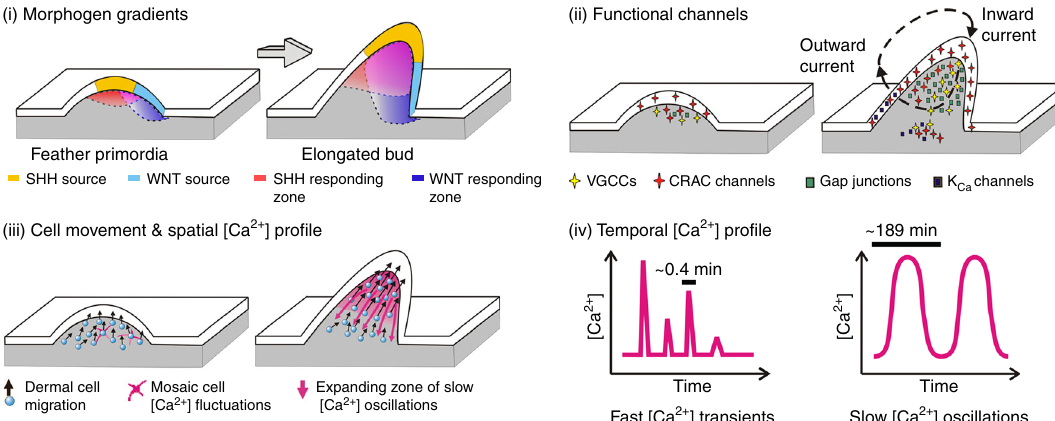
Fig. 9 Biochemical and bioelectric signals guiding directed mesenchyme cell migration in feather. SHH and WNT7A protein produced in the epithelium diffuse into the underlying mesenchyme to induce the SHH and WNT-responding zone, respectively. Together they activate Connexin-43 expression to compose intercellular gap junction channels. Heterogeneously distributed VGCCs and CRAC channels contributed to the inward current observed at posterior – distal part of elongating feathers, while activation of Ca 2 + -activated K + channels may contribute to the outward current at anterior-basal part of feathers. The gap junction network establishes a low-resistance electrical path across feather mesenchyme, homogenizing differential Ca 2 + channel activities among cells to allow synchronized Ca 2 + oscillations to form. These slow oscillations coordinate the collective migration of mesenchymal cells. Meanwhile much faster Ca 2 + transients occur sporadically in individual